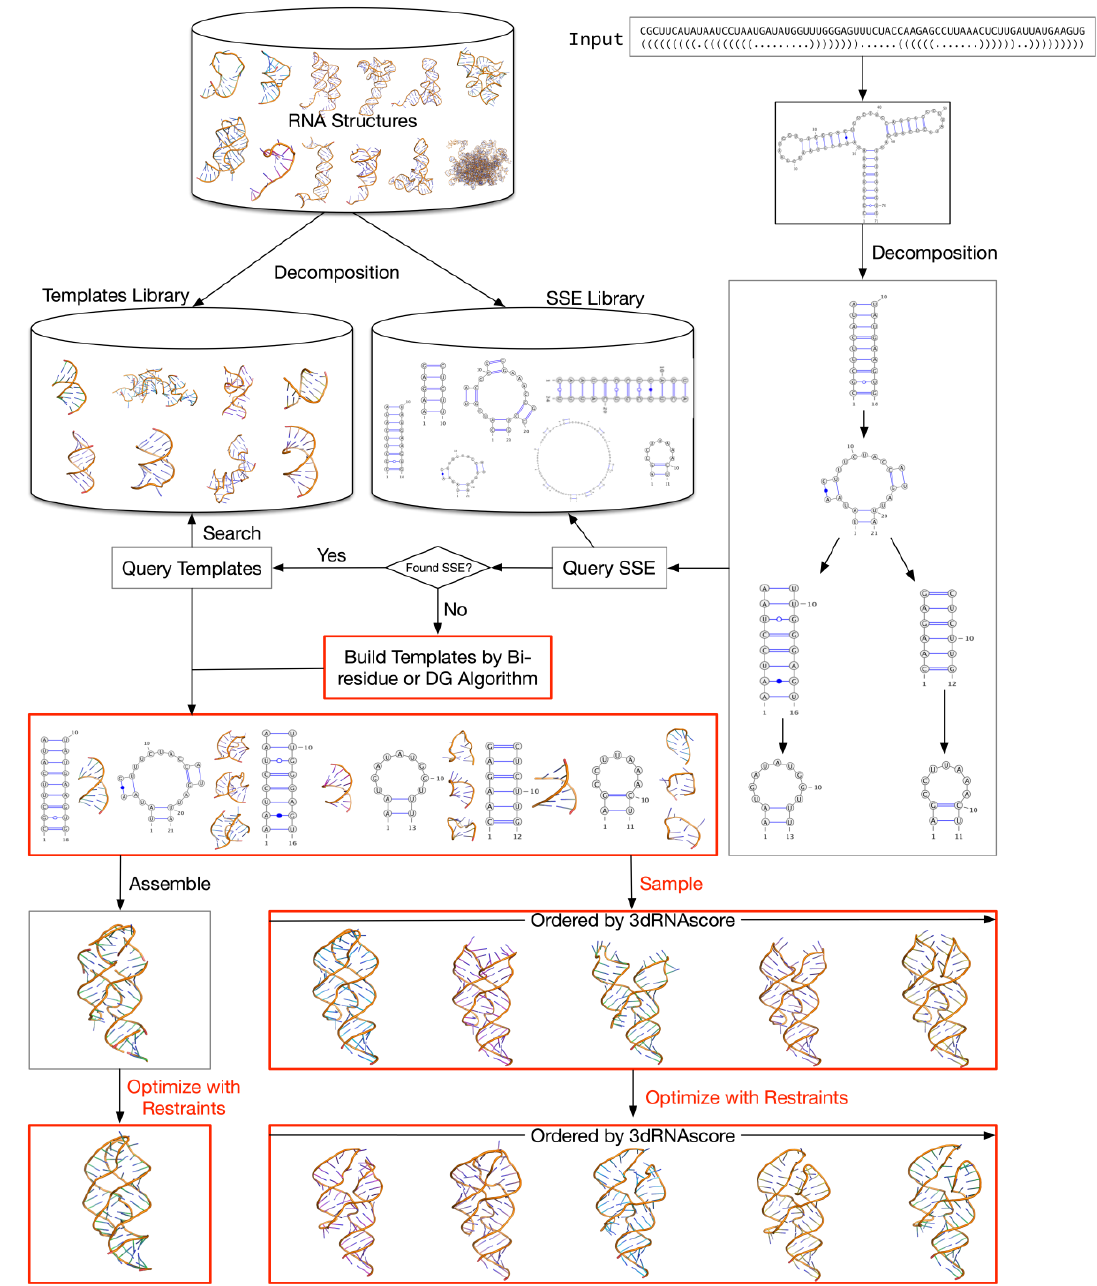
Figure 1. Schematic diagram of the prediction process of an RNA with pseudoknot (PDB ID: 1Y26 [30]) using 3dRNA v2.0. The red colored parts of this diagram are the new features compared with our previous web